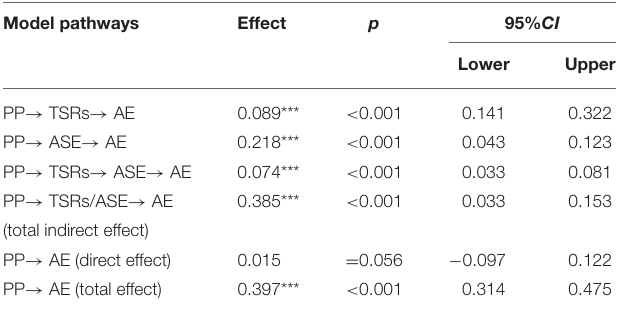
TABLE 2 | Bootstrap analyses of magnitude and statistical significance of indirect effects. Model